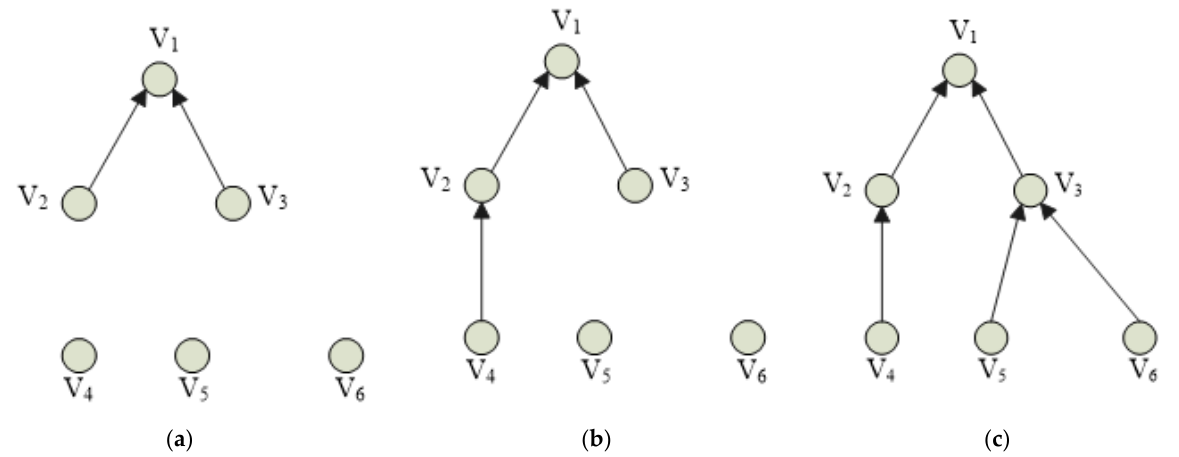
Figure 7. Example of constructing a routing tree. ( a ) V 1 broadcasts the tree building message, V 2 and V 3 join the routing tree ( b ) Node V 2 , V 3 keep broadcasting, V 4 node joins the routing tree, ( c ) V 5 and V 6 nodes join the routing tree separately.